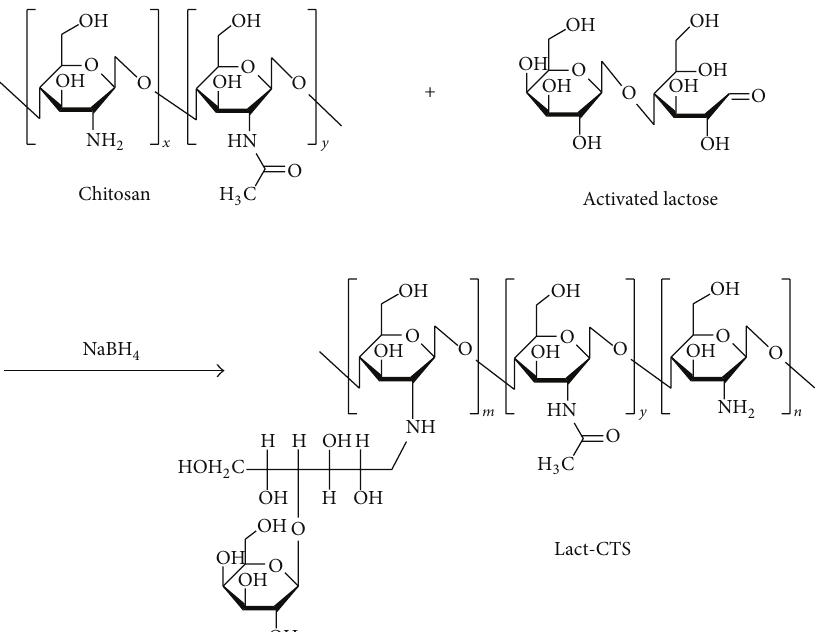
Figure 2: The scheme of Lact-CTS synthesis.